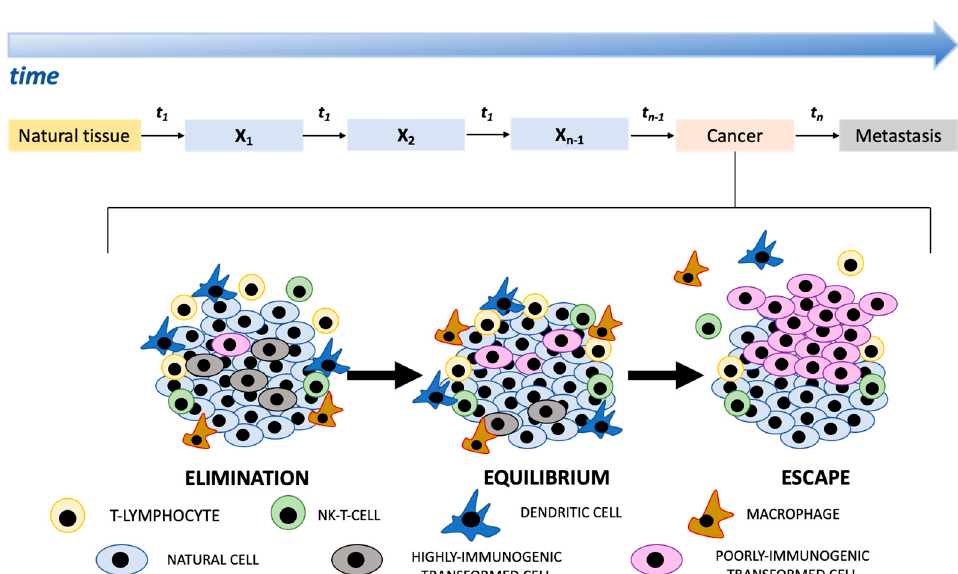
Figure 1. The cartoon shows the progression of different states (x 1 , x 2 , . . . , x n − 1 , x n ) identifiable in the development of cancer from natural tissue. The exact time interval (t) between two successive states is unpredictable. Understanding how the immune system affects cancer progression still remains one of the most important topics in cancer immunology. Elimination, equilibrium, and escape represent three states that function either independently or in sequence in which a different relation between transformed cells and the immune system is established. The entire process is called “cancer immunoediting”.